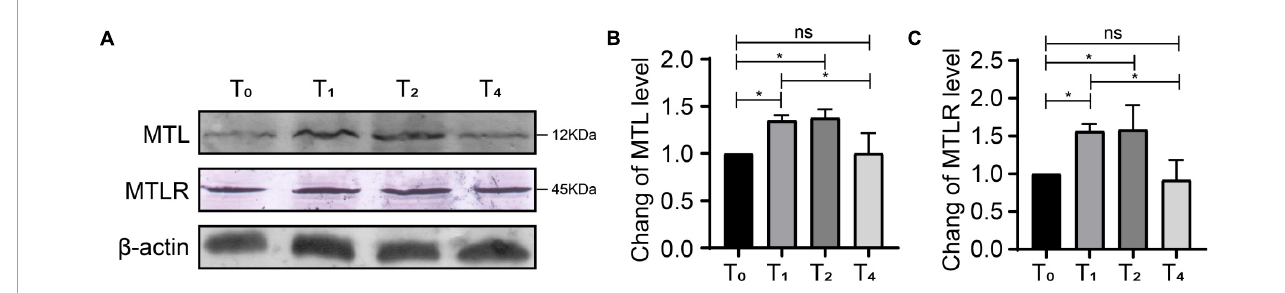
FIGURE6 Dynamic changes of motilin (MTL) and MTL receptor (MTLR) in the dorsal horn in rats with acute incisional pain. (A) Western blot. (B) MTLR. (C) MTL. n = 6 rats/group/time point. ns, not significant; * P < 0.05. P0, 24 h before surgery; P1, 2 h after surgery; P2, 24 h after surgery; and P4, 72 h after